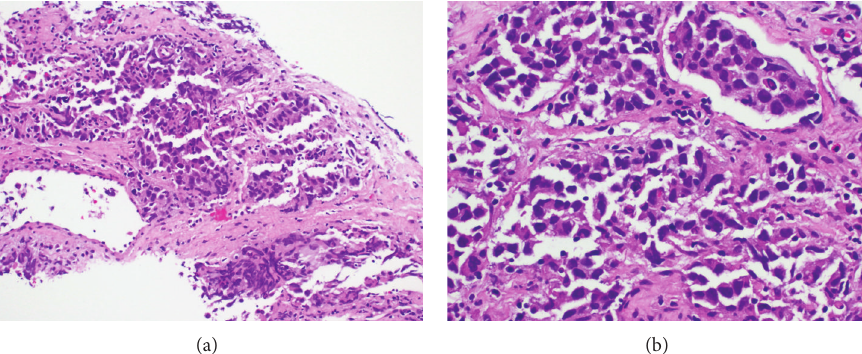
Figure 2: (a) Foci of neoplastic cells consistent with germ cell tumor (H&E). (b) Foci of neoplastic cells consistent with germ cell tumor (Medium Power, H&E).